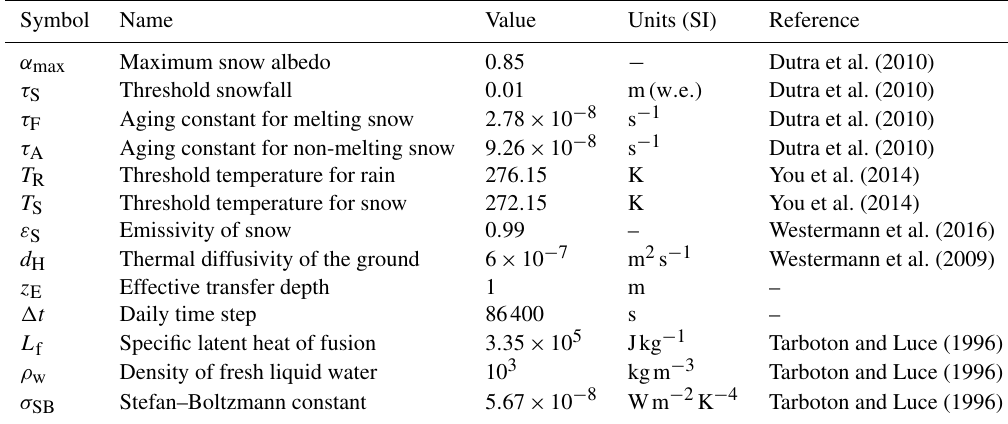
in which S ↓ and L ↓ are the downwelling shortwave and long- wave irradiances, and the last term is the upwelling long- wave radiation for the assumed isothermal snowpack at T 0 = 273 . 15K. The snow albedo ( α S ) is parametrized prognos- tically through the continuous reset formulation following Dutra et al. (2010), which computes the albedo for time